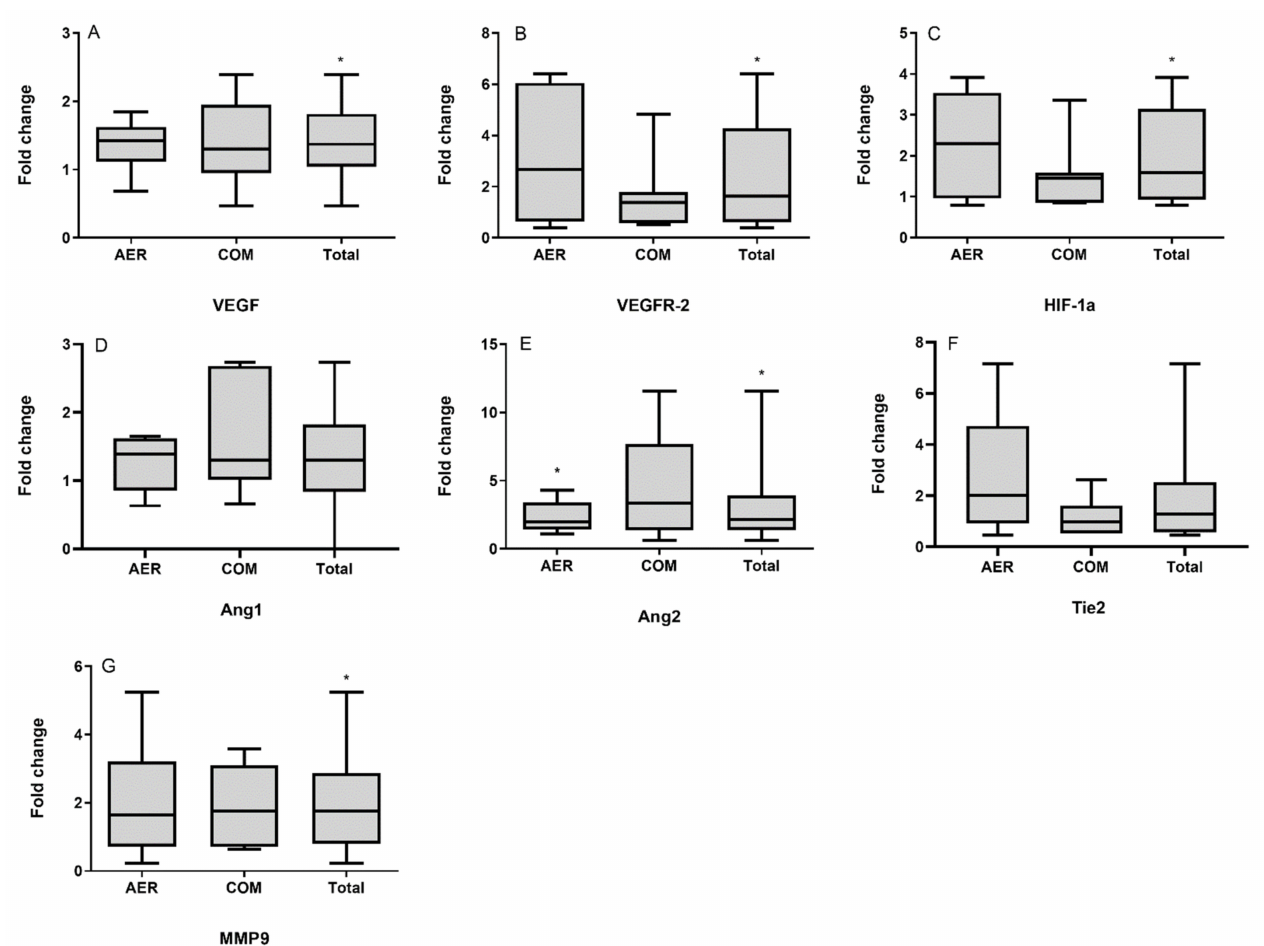
Figure 1. Box-plot diagrams showing the changes in the mRNA expression of vascular endothelial growth factor (VEGF; A ), vascular endothelial growth factor receptor 2 (VEGFR-2; B ), hypoxia-inducible factor 1 alpha (HIF-1 α ; C ), angiopoietin 1 (Ang1; D ), angiopoietin 2 (Ang2; E ), angiopoietin receptor (Tie2; F ), and matrix metallopeptidase 9 (MMP9; G ) in the skeletal muscle of heart failure patients following either high-intensity-interval training (HIIT; N = 6) or combined HIIT with strength exercise training (COM; N = 7) and in the total number of patients ( N = 13). * Significantly different compared to pre-exercise levels p < 0.05.